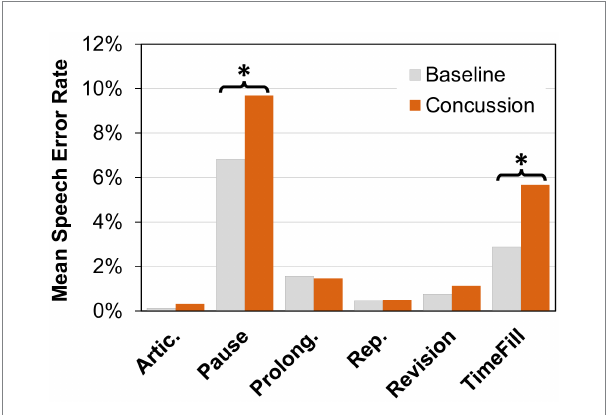
FIGURE 2 Mean speech error rate (percent) for articulation errors (Artic.), pauses, prolongations, (Prolong.), repetitions (Rep.), revisions, and time fillers (TimeFill) at baseline and after concussion. A significant difference between conditions ( α = 0.05 level) is indicated by an asterisk (*).